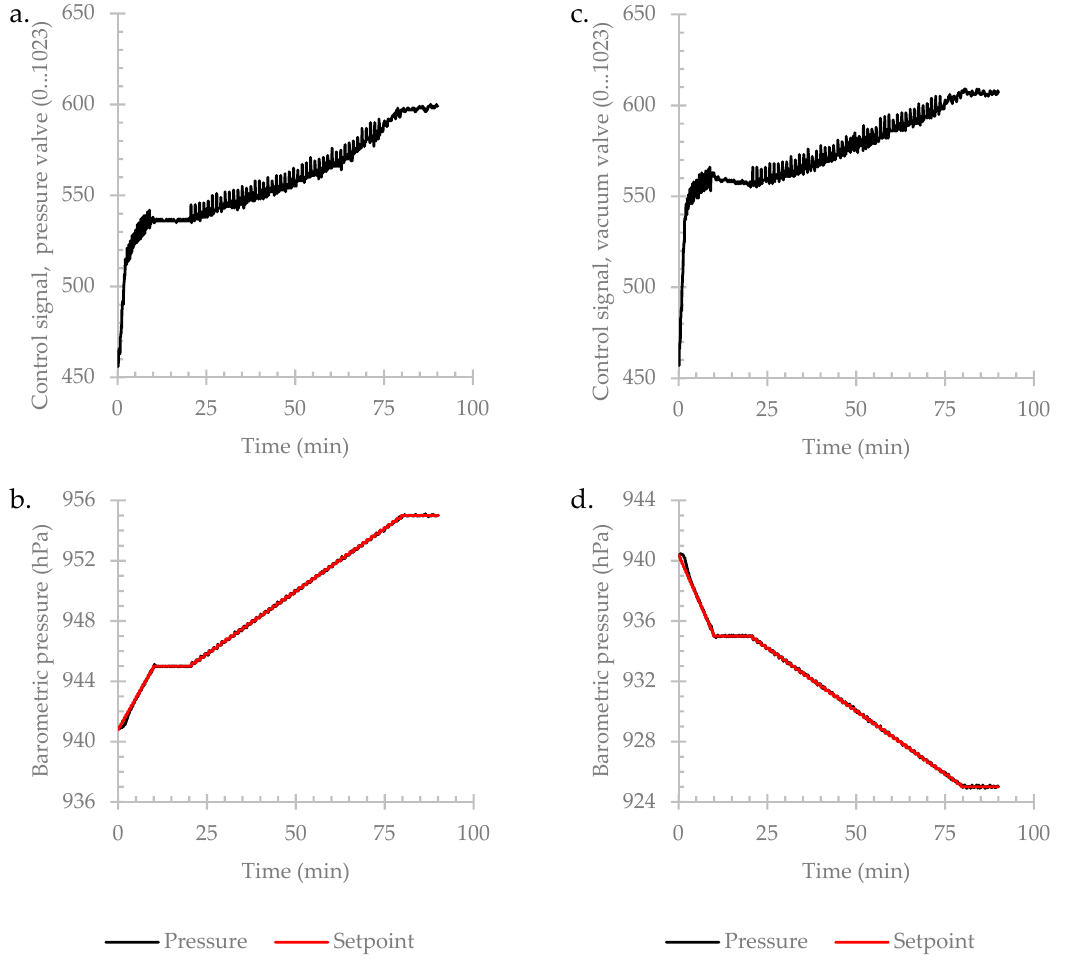
Figure 9. Results of short-term tests run to demonstrate that the chamber works as expected: ( a ) test 1—control signal fluctuations while controlling the pressure valve; ( b ) test 1—rising pressure within the barometric chamber; ( c ) test 2—control signal fluctuations while controlling the vacuum valve; ( d ) test 2—decreasing pressure within the barometric chamber.